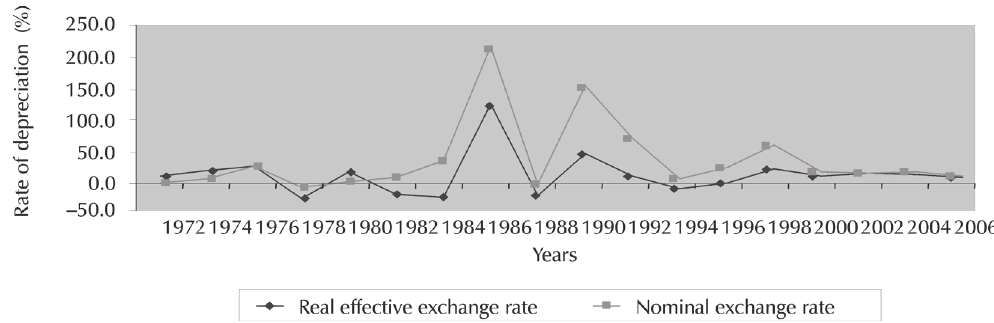
Nominal and real exchange rate